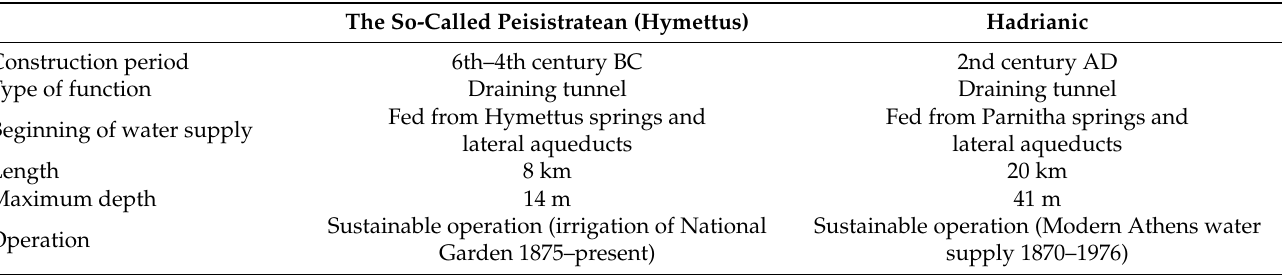
( d ) Figure 16. (a – d) Different views of the tunnel of the Hadrianic aqueduct. The Hadrianic aqueduct followed the technological knowledge of the Greeks [72–78], as the Romans preferred to build aqueducts like bridges to transfer water. Table 1 and Figures 17 and 18 compare the Hadrianic aqueduct with the so-called Peisistratean (Hy- mettus) aqueduct, showing impressive similarities. The first construction phase of the original aqueduct of Peisistratos was 6th c. B.C. This aqueduct had a network of clay pipes and unknown feed. The archaeologist Olga Voyatzoglou noted that, around 5th c. B.C., the archaic installations were dismantled in